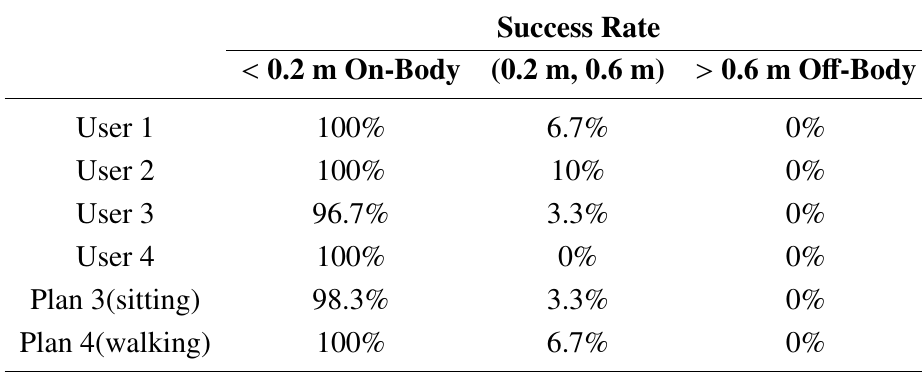
Table 6. Authentication